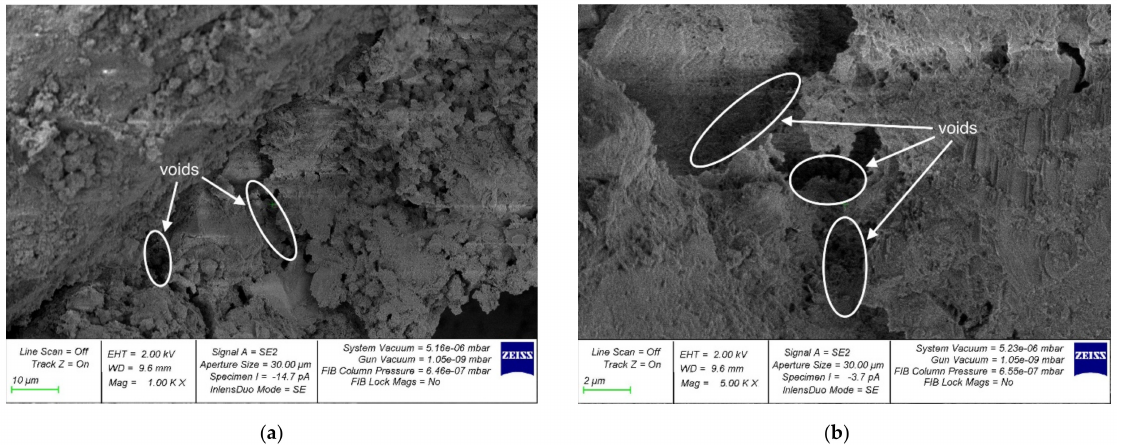
Figure 16. Photographs of the microstructure of a sample of the hardened cement paste of the control composition: ( a ) 1000 × ; ( b ) 5000 × .